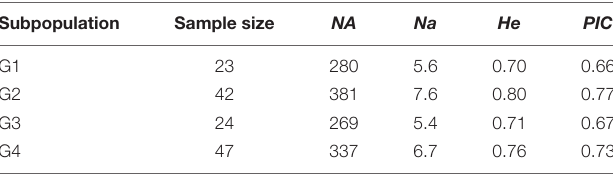
TABLE 3 | Summary statistics for subpopulations as identified by STRUCTURE analysis based on 50 SSR